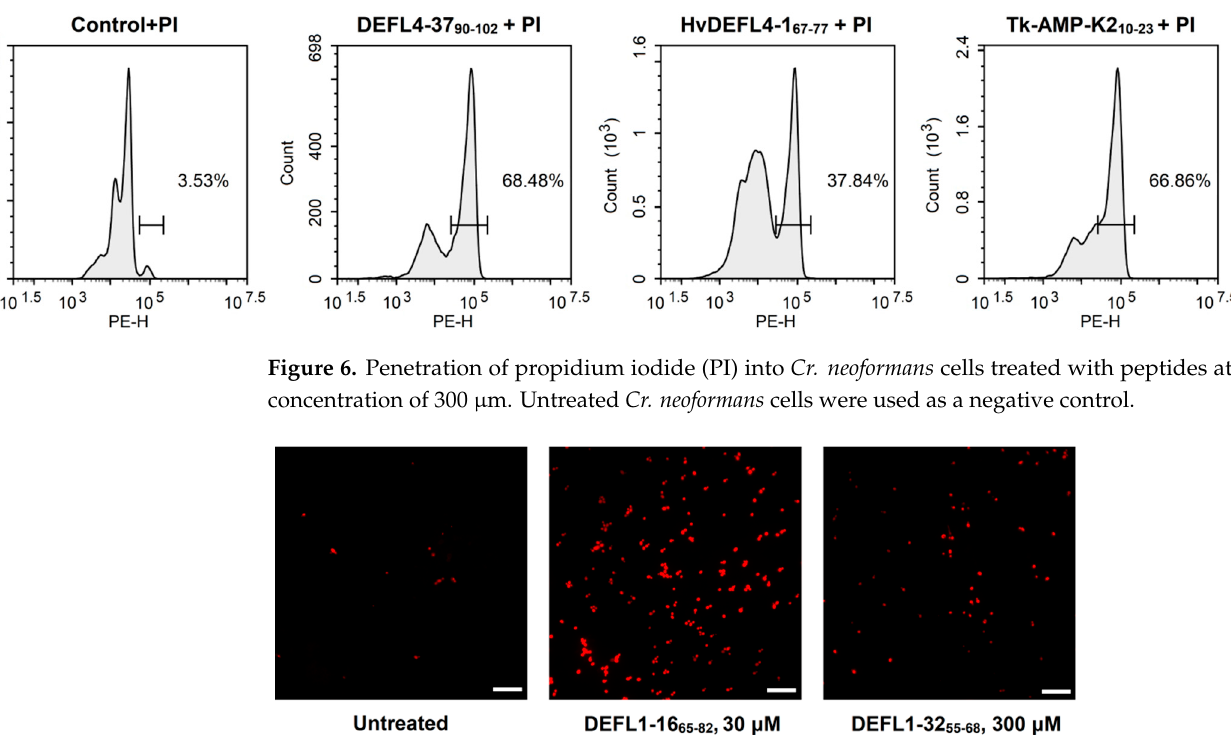
Figure 5. Fluorescence microscopy images of Cr. neoformans cells incubated in the presence of peptides and stained with propidium iodide. Untreated Cr. neoformans cells were used as a negative control. Scale bar = 20 μ m.